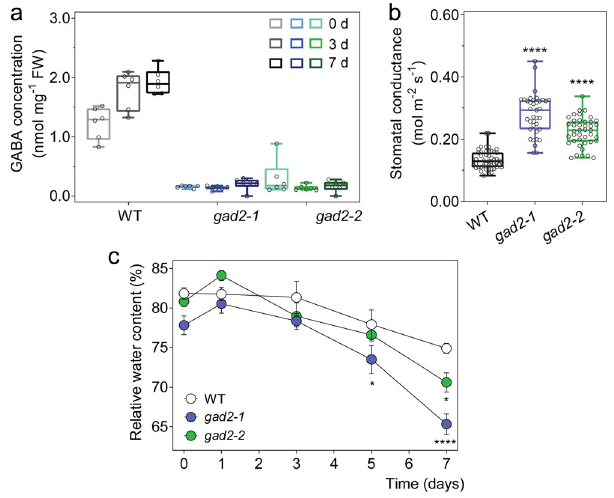
Fig. 3 Leaf GABA concentration regulates transpiration. a Leaf GABA concentration of 5 – 6-week-old A. thaliana wild-type (WT), gad2-1 and gad2- 2 plants following drought treatment for 0, 3 and 7 days, n = 6. b Stomatal conductance of Arabidopsis WT, gad2-1 and gad2-2 plants determined using an AP4 porometer; n = 48 for WT, n = 37 for gad2-1 and n = 41 for gad2-2 , data collected from three independent batches of plants. c Relative leaf water content of WT, gad2-1 and gad2-2 plants following drought treatment for 0, 1, 3, 5 and 7 days, n = 6. All data are plotted with box and whiskers plots: whiskers plot represents minimum and maximum values, and box plot represents second quartile, median and third quartile ( a , b ), or data are represented as mean ± s.e.m ( c ); statistical difference was determined using two-way ANOVA ( a , c ) or one-way ANOVA ( b ); *P < 0.05 and ****P < epidermal strips attenuated stomatal responses of other plant species to light or dark transitions, including the dicot crops Vicia faba (broad bean), Glycine max (soybean) and Nicotiana benthamiana (tobacco-relative) and the monocot Hordeum vulgare (barley) (Supplementary Fig. 5). The widespread inhibi- tion of stomatal pore aperture changes suggests that GABA has the potential to be a universal ‘ brake ’ on stomatal movement in plants, including valuable crops. WUE (Fig. 2d; Supplementary Fig. 2c) — key factors under- pinning drought tolerance 27 — implicates GABA as novel signal regulating plant drought resilience. Therefore, to examine the hypothesis that endogenous GABA concentration increases under a water de fi cit and acts as a signal, we fi rst determined whether we could replicate the previously reported increases in GABA accumulation under drought 13,14,29 (Fig. 3; Supplemen- tary Fig. 6). In wild-type plants, a drought treatment was applied by withholding watering, which resulted in the gradual depletion of soil gravimetric water and a reduction in leaf relative water content (RWC) (Supplementary Fig. 6a, b). We found that GABA accumulation in drought stressed leaves increased by 35% compared to that of well-watered leaves (water versus drought at